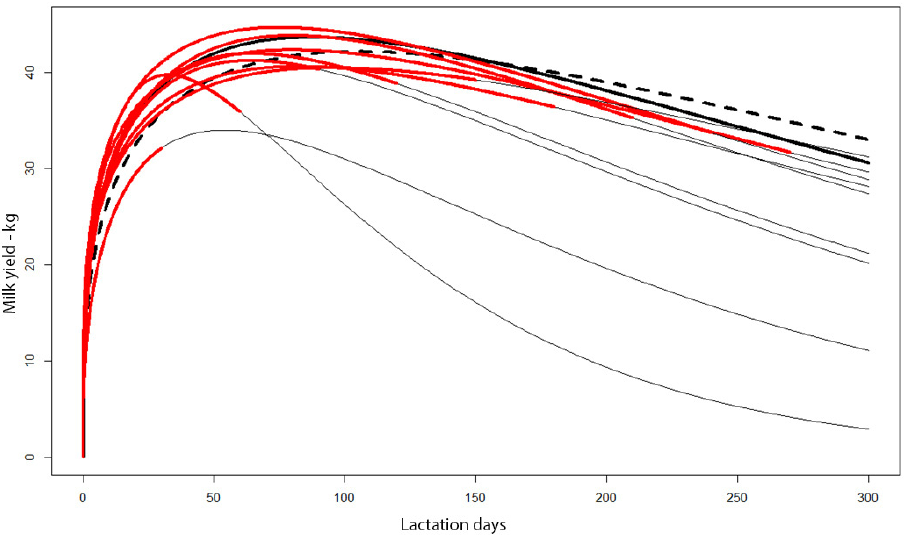
Figure 3. Milk yield curves for cows culled after day x of milking (red lines), extended based on predictions made using the Wood function (thin black lines). Total curve for cows milked for 305 days and those with shortened lactation (dashed line). Curve for cows milked at least 305 days (thick black line).